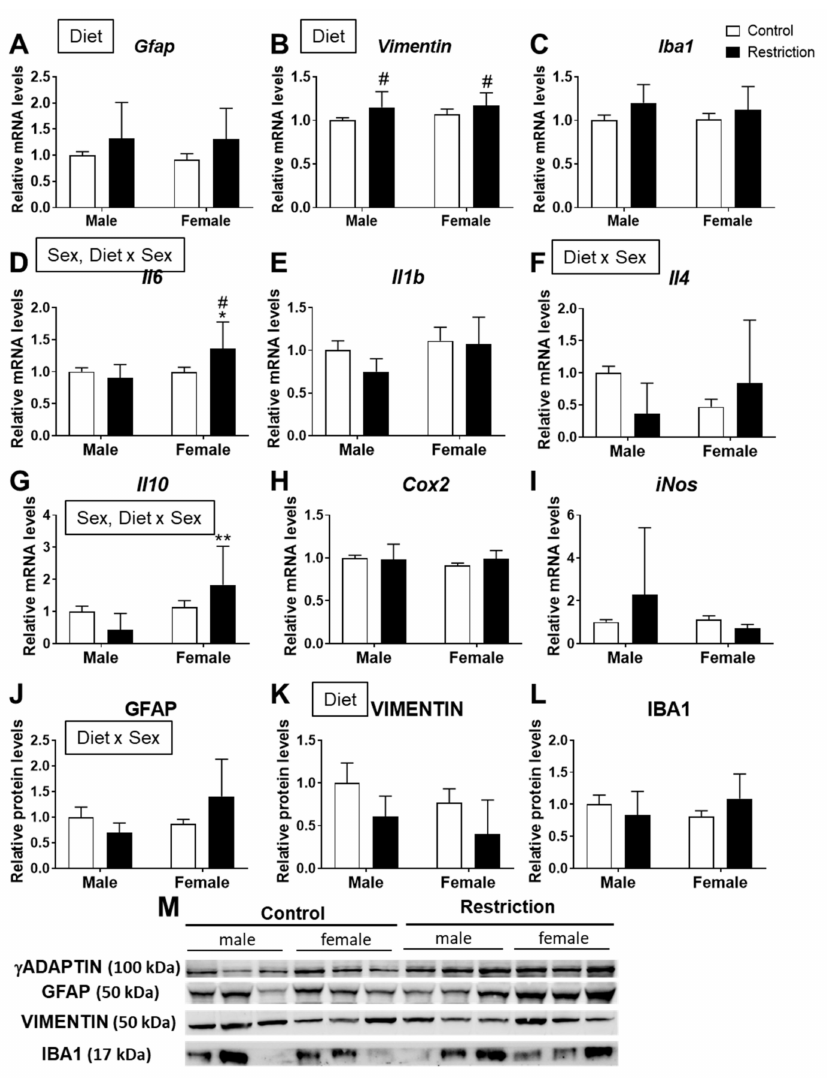
Figure 2. Effect of maternal caloric restriction on the relative mRNA ( Gfap ( A ), Vimentin ( B ), Iba1 ( C ), Il6 ( D ), Il1b ( E ), Il4 ( F ), Il10 ( G ), Cox2 ( H ) and iNos ( I )) and protein (GFAP ( J ), VIMENTIN ( K ) and IBA1 ( L )) levels of neuroinflammation-related genes in the hypothalami of male and female offspring at postnatal day 2. Representative membranes of the main changes ( M ). Data are expressed as the mean ± S.E.M. (control male: n = 11; restriction male: n = 9; control female: n = 10; restriction female: n = 6). Tukey or single-effect analysis: */** p < 0.05/0.01 vs. males (sex difference); # p < 0.05 vs. same-sex control